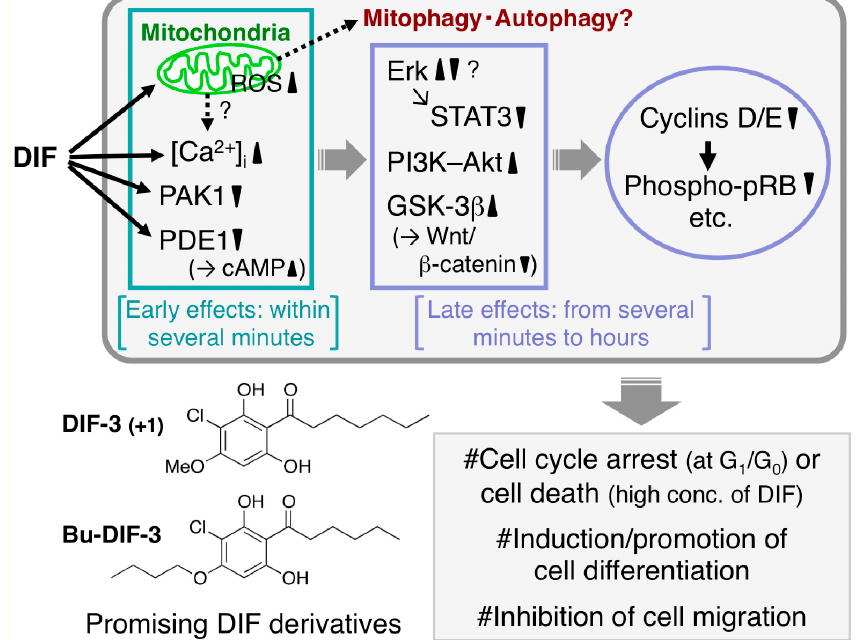
Figure 4. Proposed scheme of the antitumor effects of DIFs. After the addition of one of the DIFs to tumor cells, the DIF rapidly (within several minutes) disturbs mitochondrial function [69,77], increases reactive oxygen species (ROS) production [69] and intracellular calcium concentration ([Ca 2+ ] i ) [63,64,69,77] and inhibits the activities of p21 ‐ activated kinase 1 (PAK1) [74] and calmodulin ‐ dependent cAMP/cGMP phosphodiesterase (PDE1) (resulting in an increase in cAMP levels) [76]. Over time (from several minutes to hours) the DIF also affects the activities of extracellular signal ‐ regulated kinase (Erk), signal transducer and activator of transcription 3 (STAT3), phosphatidylinositol 3 ‐ kinase (PI3K)–Akt, glycogen synthase kinase ‐ 3 β (GSK ‐ 3 β ) and the Wnt/ β‐ catenin pathway, which suppresses the expression of cyclins D/E (and promotes the degradation of cyclin D1) and the subsequent reduction of phospho ‐ pRB [65,66,74,77–81]. At appropriate concentrations the DIFs have been found to induce growth arrest in all the tumor cell lines tested to date in vitro and in vivo and at higher concentrations they have induced caspase ‐ independent cell death [67–69]. Also, the DIFs induce differentiation of murine and human leukemia (B8 and K562) cells in vitro [61,64] and promote retinoic acid ‐ induced differentiation of human leukemia HL ‐ 60 cells in vitro [63]. In addition, the DIFs suppress the migration of some cancer cells in vitro and in vivo [72,82]. Chemical structure–activity relationship analyses have revealed that DIF ‐ 3 (+1) and Bu ‐ DIF ‐ 3 are promising lead compounds for the development of anti ‐ cancer drugs [72–74].